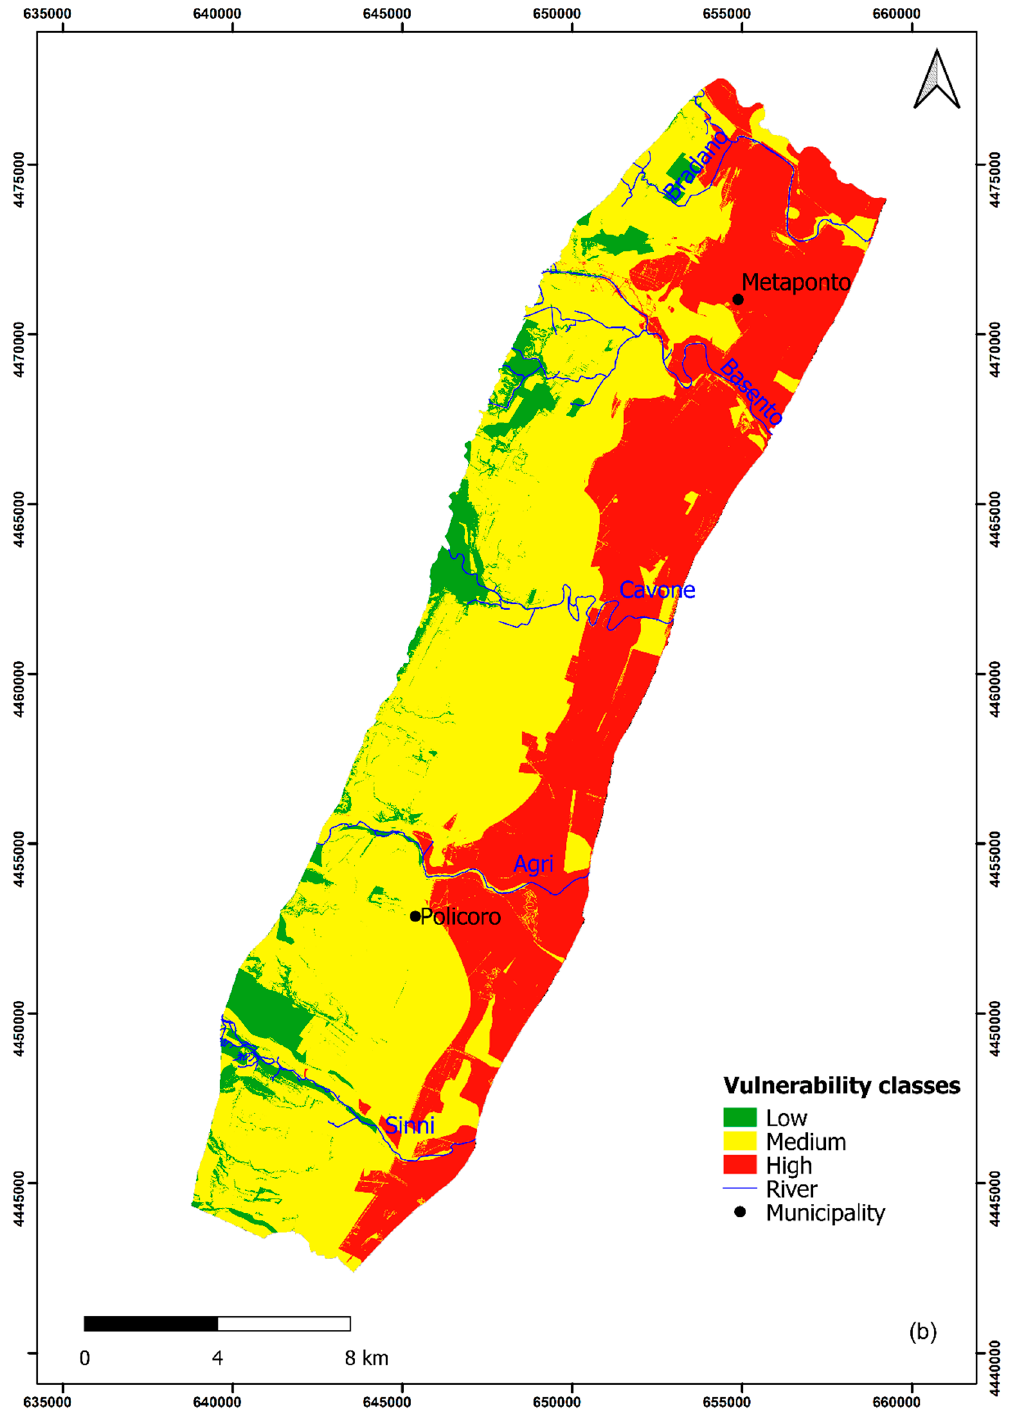
Figure 6. Groundwater vulnerability maps derived from: ( a ) SINTACS and ( b ) SINTACS-LU methods.